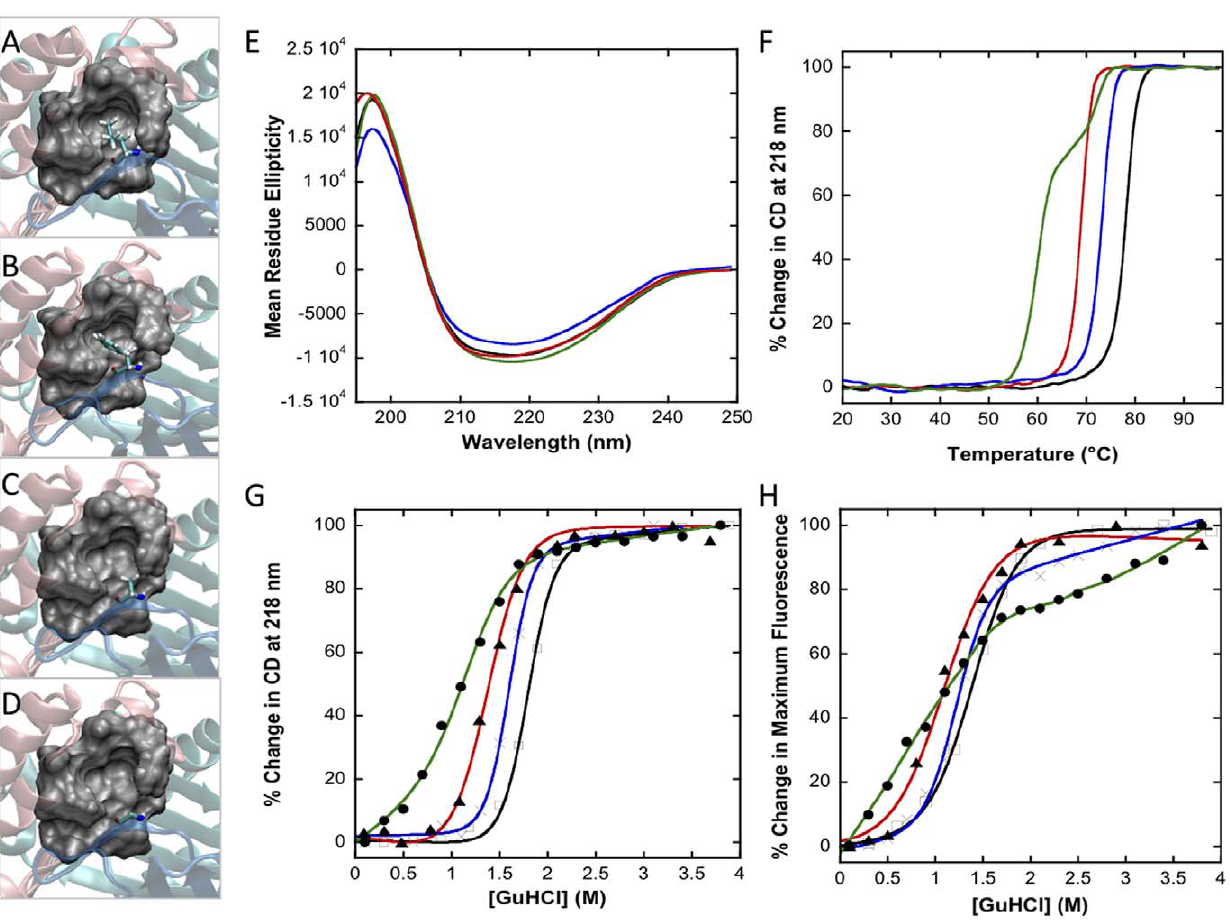
Figure 2. Disrupting the hydrophobic interactions via mutating Leu46 alters the structural stability of MIF. (A) Leu46 hydrophobic pocket of wt huMIF. VMD representations of the hydrophobic pocket, where Leu46 is mutated to a phenylalanine (L46F) (B), alanine (L46A) (C), or glycine (L46G) (D). ( E-H): The three Leu46 mutants are structurally less stable than the wild type protein, but retain the same overall secondary structure. (E) Far-UV CD spectra of wt and Leu46 mutants. (F) Thermal denaturation of wt and Leu46 mutants (at 20 m M) followed by far-UV CD at 218 nm. (G) GdnHCl denaturation studies monitored by far-UV CD at 218 nm and fluorescence spectroscopy (H), excitation wavelength: 295 nm, protein concentration: 10 m M. All spectroscopic experiments were performed in PBS 1X, pH 7.4 buffer. Black lines, wt MIF; blue lines, L46F MIF; red lines, L46A MIF; green lines: L46G MIF.